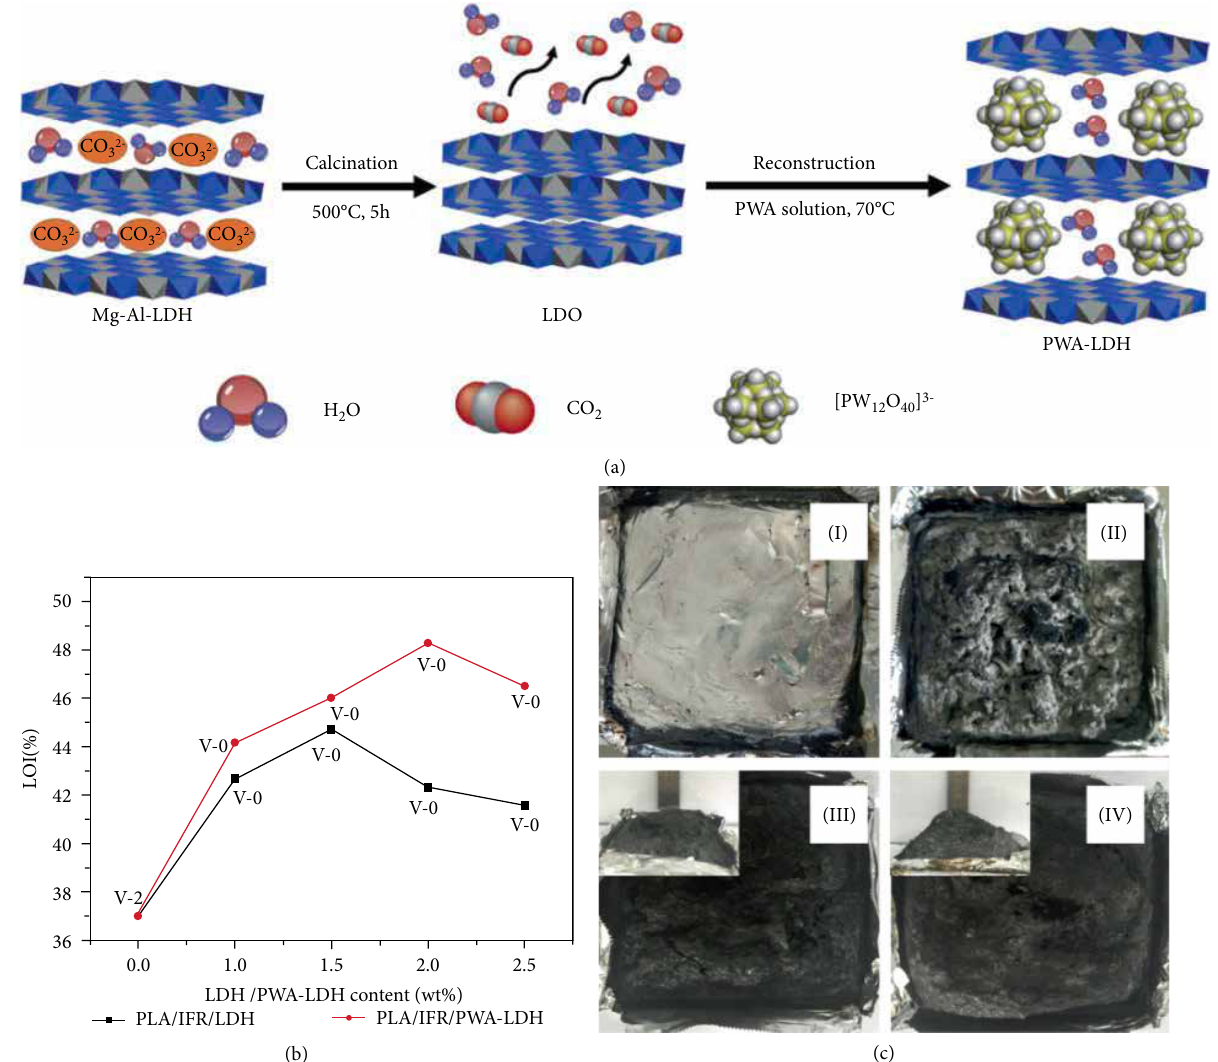
Figure 7: (a) The preparation process of PWA-LDH. (b) The LOI and UL-94 results of PLA composites. (c) Digital photos of (I) PLA, (II) PLA/IFR, (III) PLA/IFR/2.0LDH, and (IV) PLA/IFR/2.0PWA-LDH samples after cone calorimeter tests. Adapted from [167].